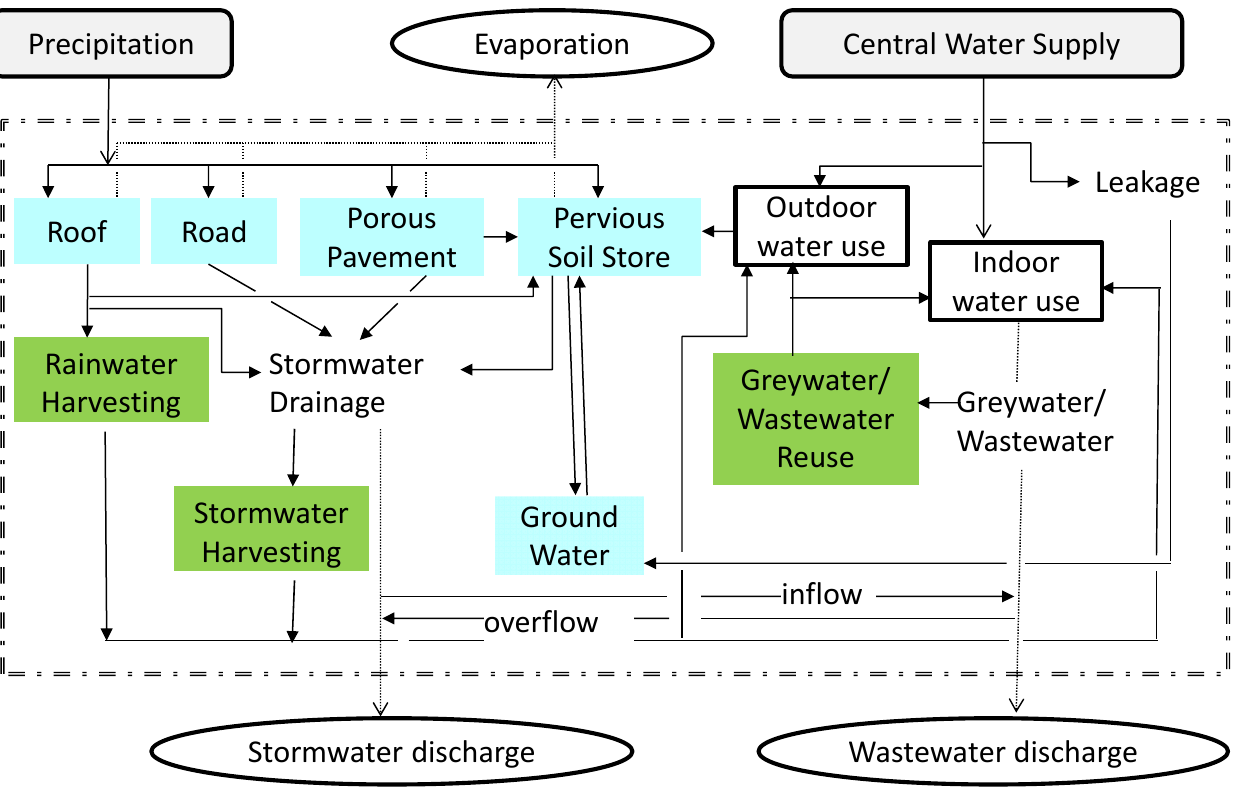
Figure 1. Urban water cycle’s main components, pathways and novel technologies (Green colored boxes indicate decentralized components of water